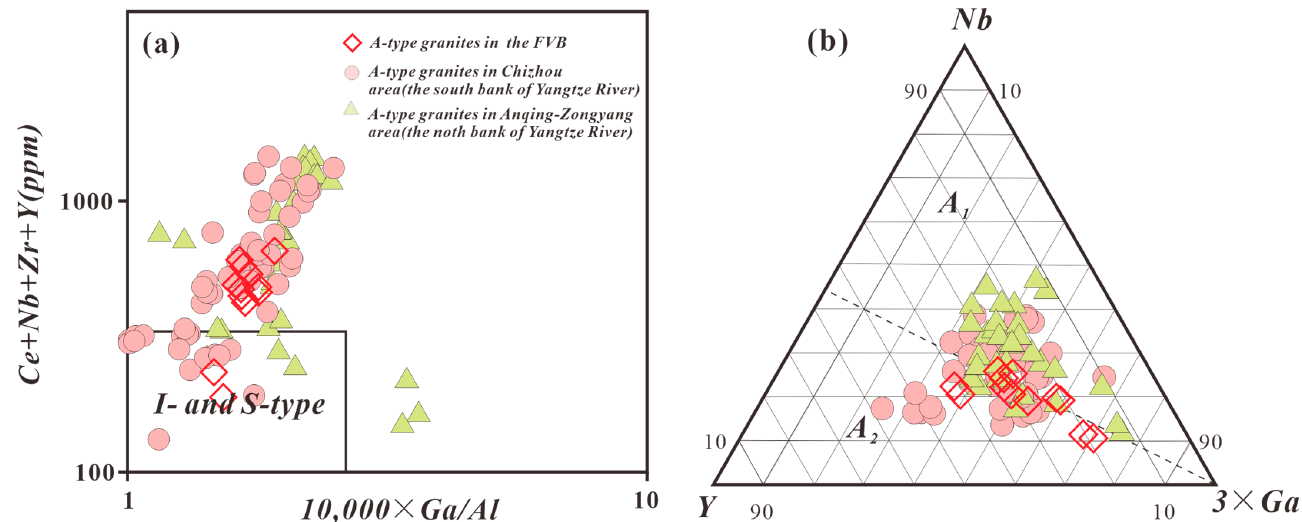
Figure 2. Discrimination diagrams of A-type granites in the MLYMB (figure ( a ) after [3] and ( b ) after [8]). Data sources: A-type granites in the FVB [46,82,85,88,89]; A-type granites in the Chizhou area (the south bank of the Yangtze River) [46,90–96]; A-type granites in the Anqing–Zongyang area (the